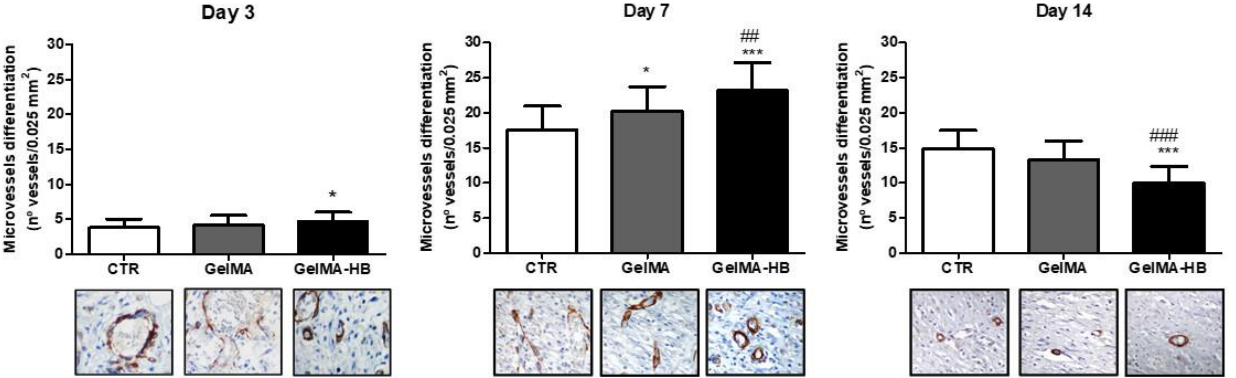
Figure 6. Assessment of microvessel differentiation (MVd) over the experimental period (data presented as mean ± standard deviation). CTR (untreated control); GelMA (wounds filled with GelMA); GelMA-HB (wounds filled with GelMA containing 2% ethanolic extract of H. bracteatus ). Significant differences compared to CTR are expressed as * p < 0.05 and *** p < 0.001; significant differences in relation to GeLMA are expressed as ## p < 0.01 and ### p < 0.001 (ANOVA, followed by Tukey’s multiple comparisons test). The photomicrographs at the base of the figure constitute histological sections representing the pattern of positive immunostaining for CD105 in endothelial cells of capillary blood vessels in the different groups throughout the experimental period (SABC,